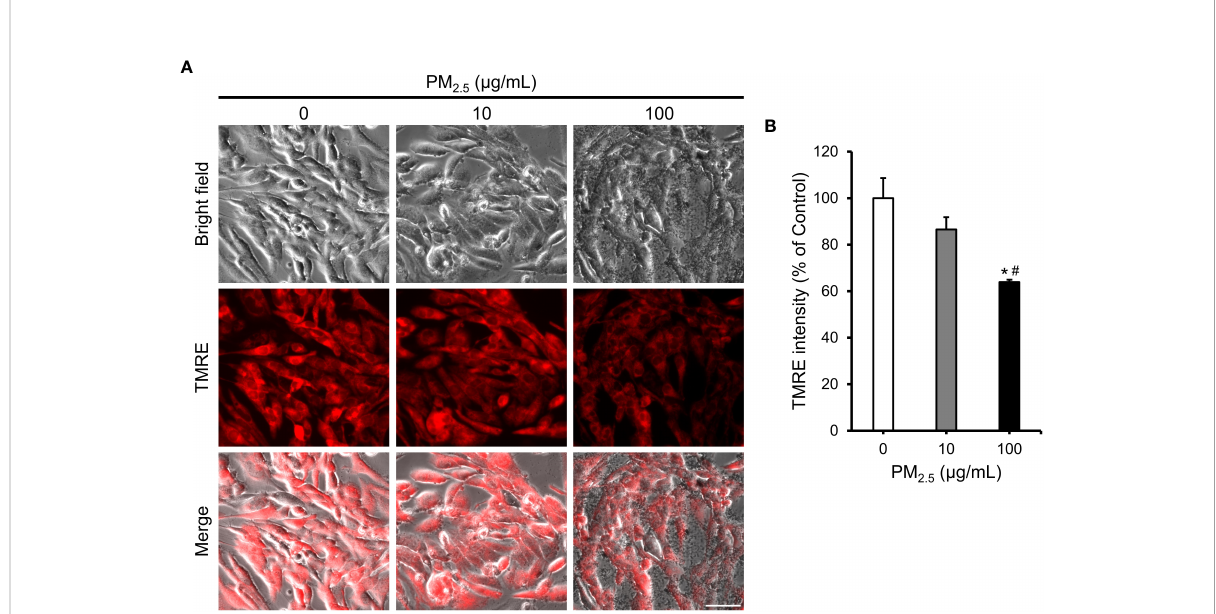
FIGURE 5 Reduction in mitochondrial membrane potential in PM 2.5 -treated HL-1 cells. (A) TMRE staining and bright- fi eld images of PM 2.5 -treated cells. Scale bar = 50 m m. (B) Measurement of TMRE intensity in 0, 10, and 100 m g/mL PM 2.5 -treated cells. Data represent independently performed triplicate experiments. * p -value < 0.05 vs. control; # p -value < 0.05 vs. 10 m g/mL PM 2.5 -treated